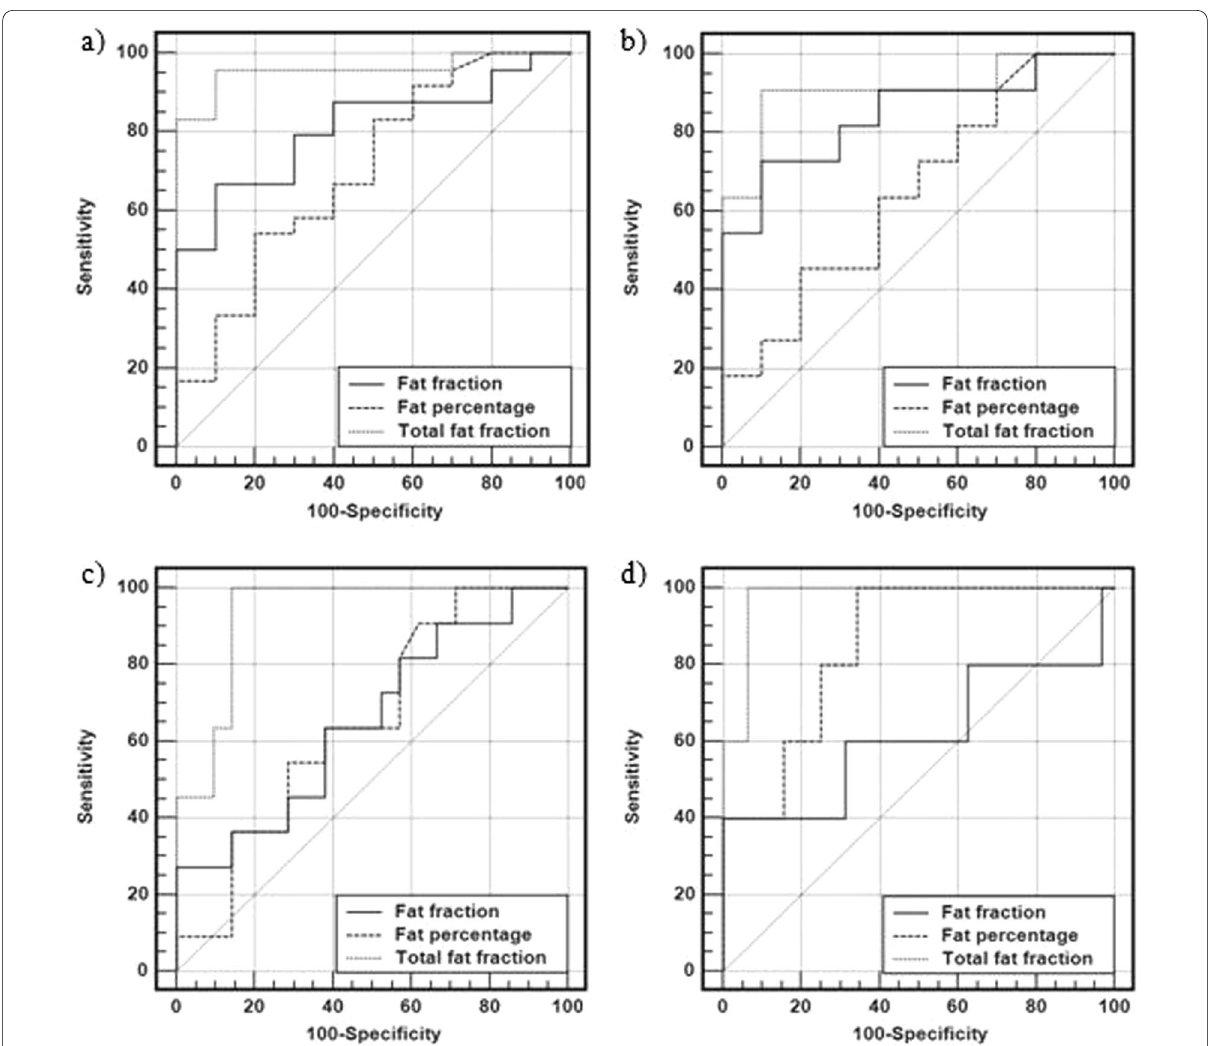
Fig. 3 Area under the receiver operating characteristic curve (AUC) of MRI parameters to predict a liver steatosis, b mild steatosis, c moderate steatosis, d severe steatosis, whereas proton density fat fraction had the highest AUCs in the prediction of steatosis and its different grades